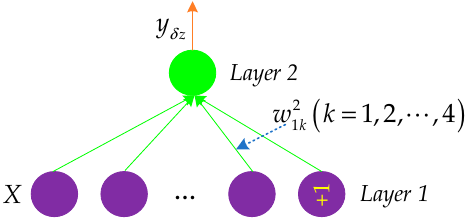
Figure 8. The structure of the deep neural network used in the attitude subsystem. As can be seen in Figure 8, the input layer X is defined as X δ z = (cid:3) = (cid:2) w 2 W 2 , w 2 , w 2 , w 2 . Then, the output of the neural network can be δ z δ z 11 δ z 12 δ z 13 δ z 14